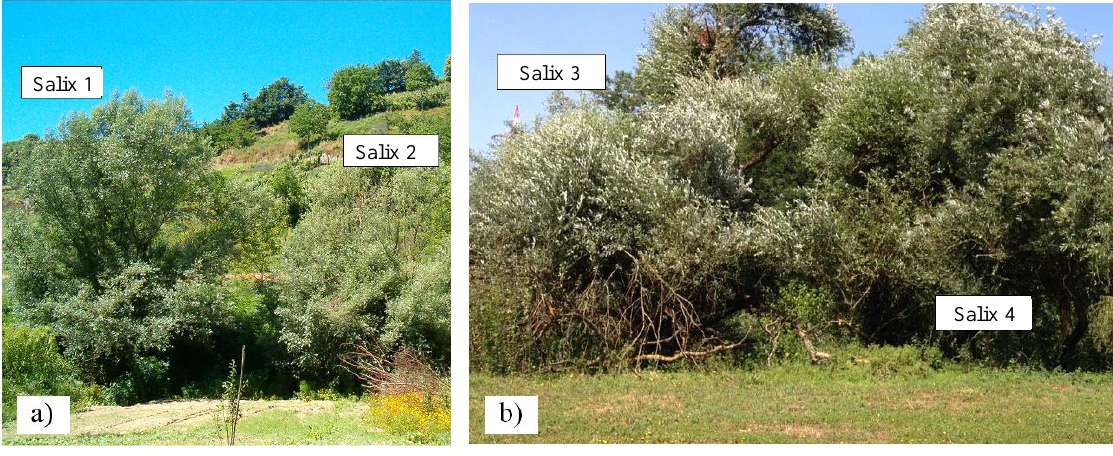
Figure 5. Salix monitored in Locations ( a ) 1 and ( b )